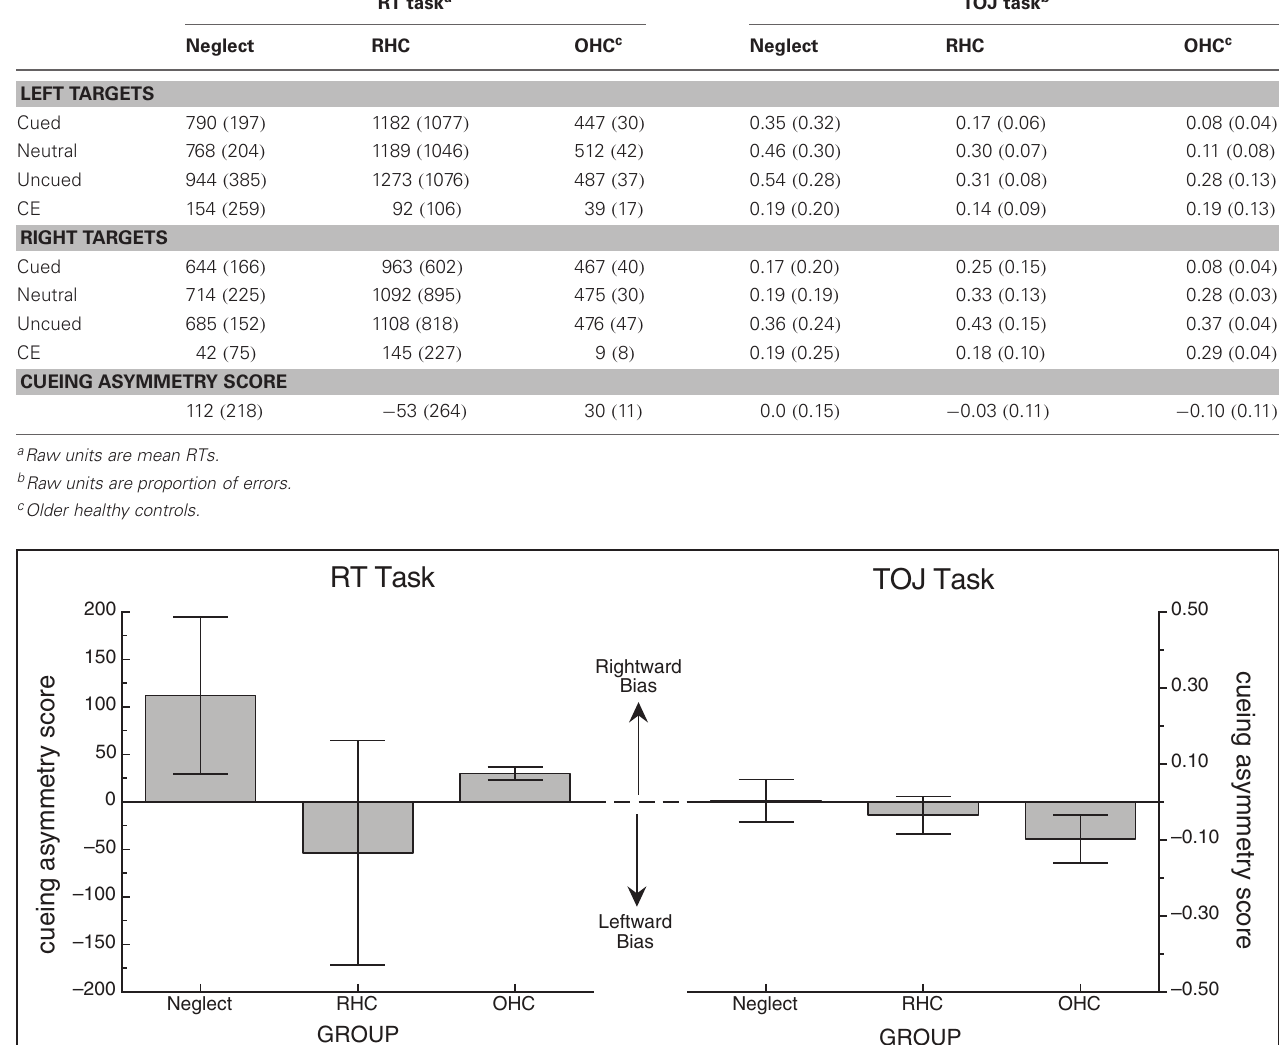
deficit than a standard disengage deficit, albeit the paradoxical disengage deficits were smaller in terms of the absolute